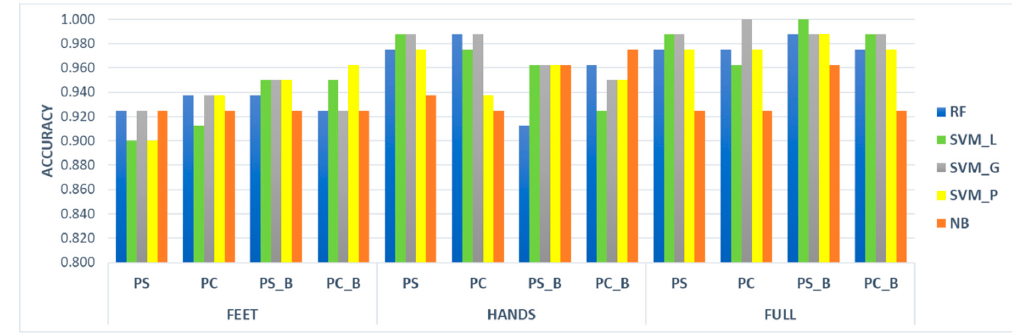
Figure 3. Accuracy index assessed by the five classifiers when applied to the four datasets over the FEET, HANDS, and FULL conditions.